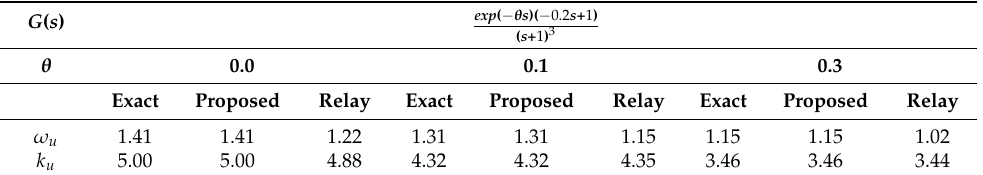
Table 5. Estimates of the proposed method and the relay feedback method [1] for the non-minimum phase process and PA set = − π .